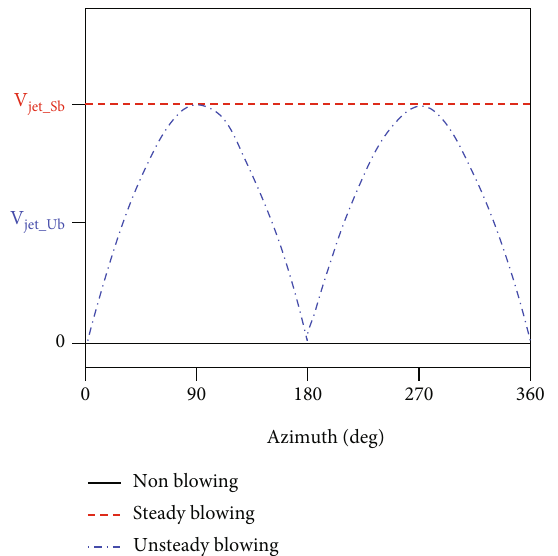
Figure 3: Jet velocity variation in the unsteady blowing case.